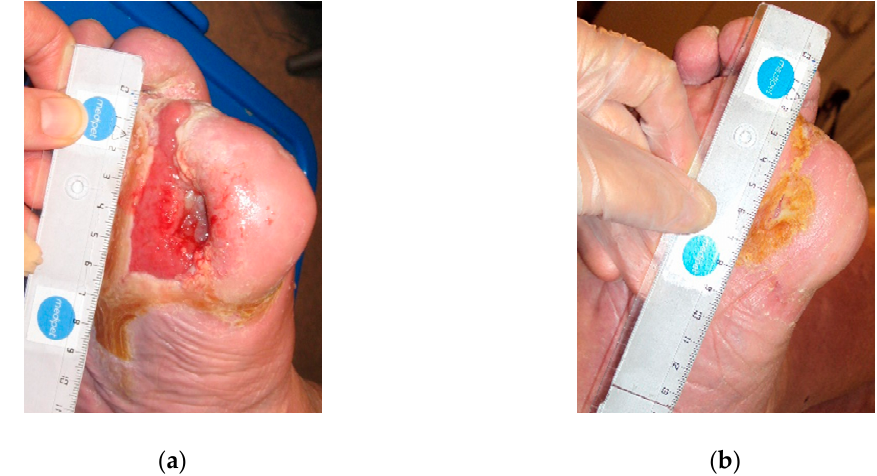
Figure 2. Case 2: ( a ) the wound one week after the start of MGH therapy; ( b ) complete healing of the wound after 34 weeks of MGH therapy.